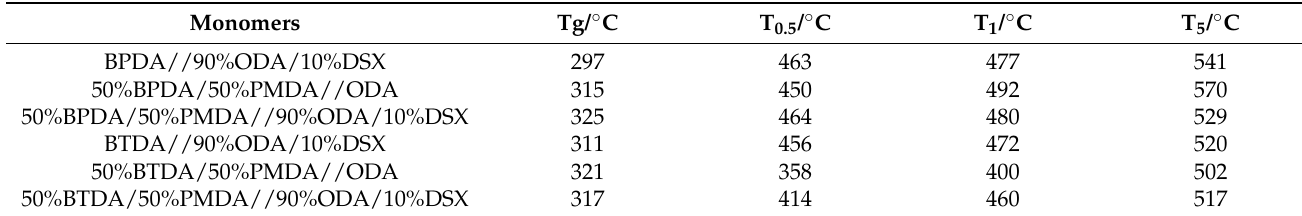
Table 3. Thermal properties of PI films in groups 2 and 3.